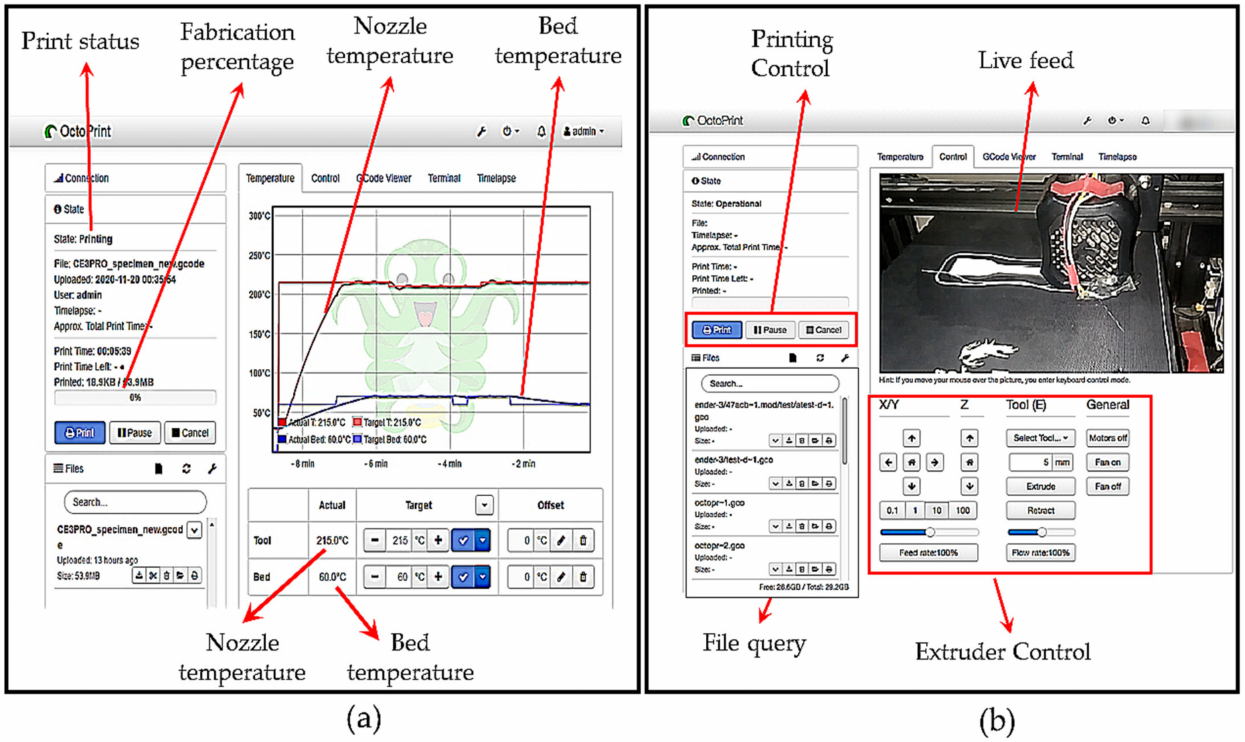
Figure 12. System Integration visualization: ( a ) printing status; ( b ) printing control.